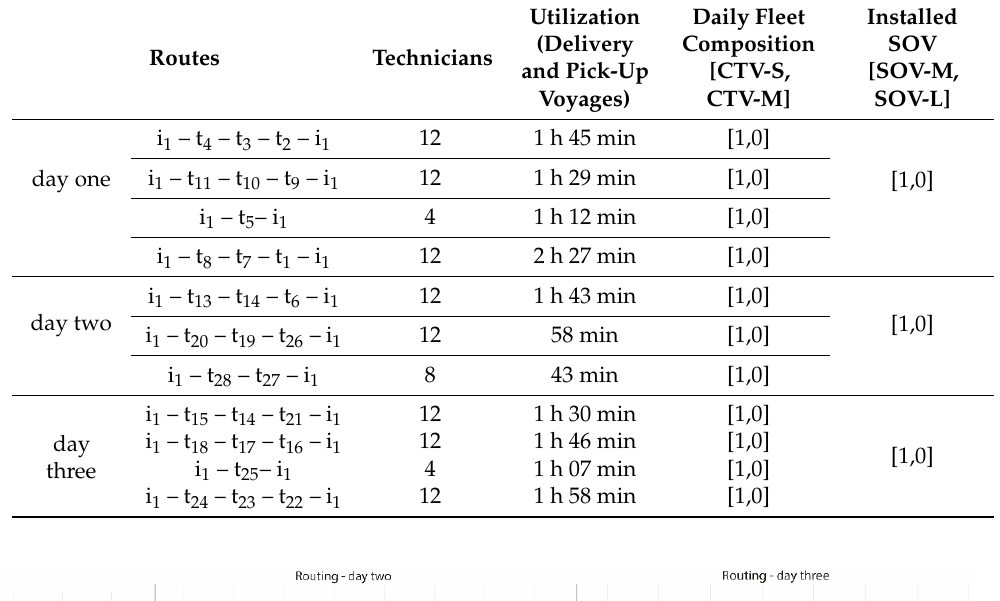
Table 3. Navigation routes per day.